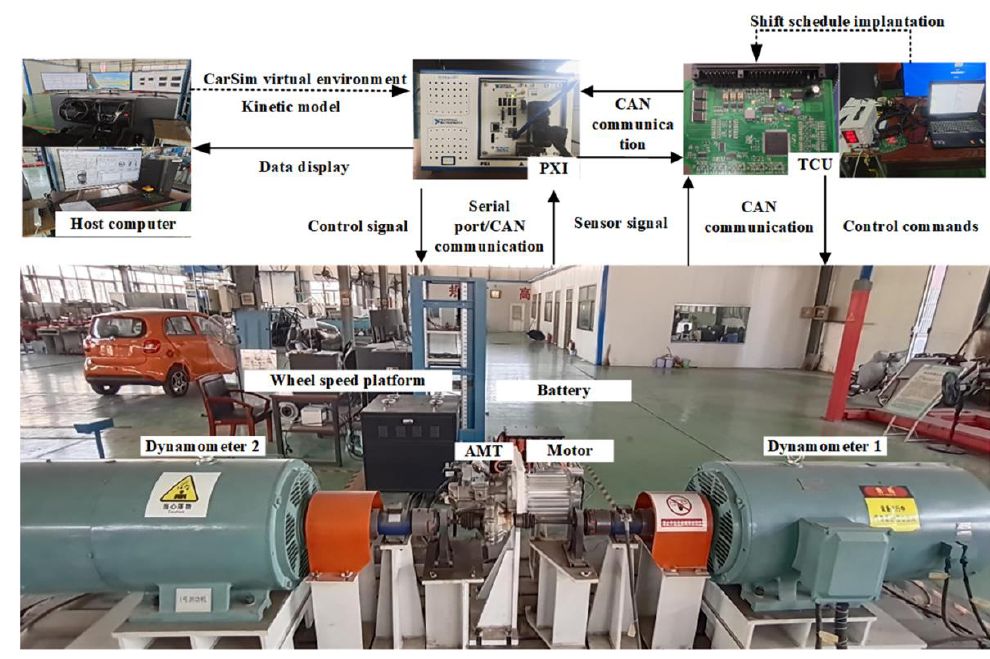
Figure 18. Hardware-in-the-loop experimental platform.